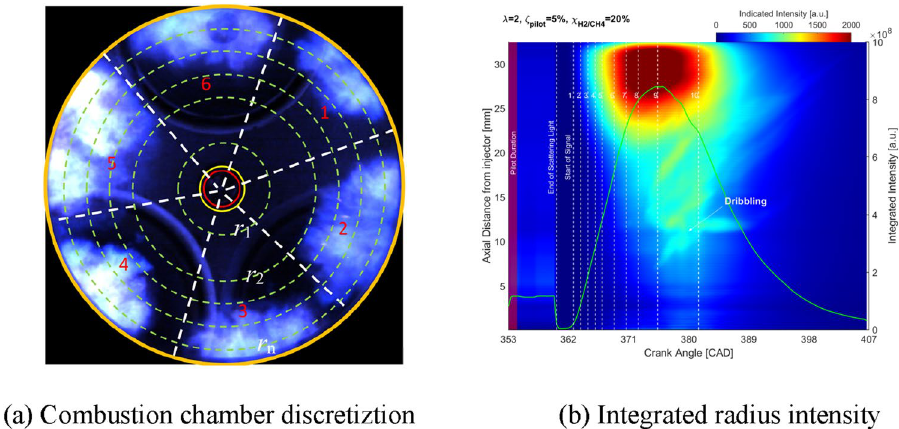
Figure 4. ( a ) Discretization of the combustion chamber radius ( r 1 , r 2 , . . . , r n ) , ( b ) integrated intensity of axial distance from injector tip I ( r n , CAD ) over 25 individual combustion